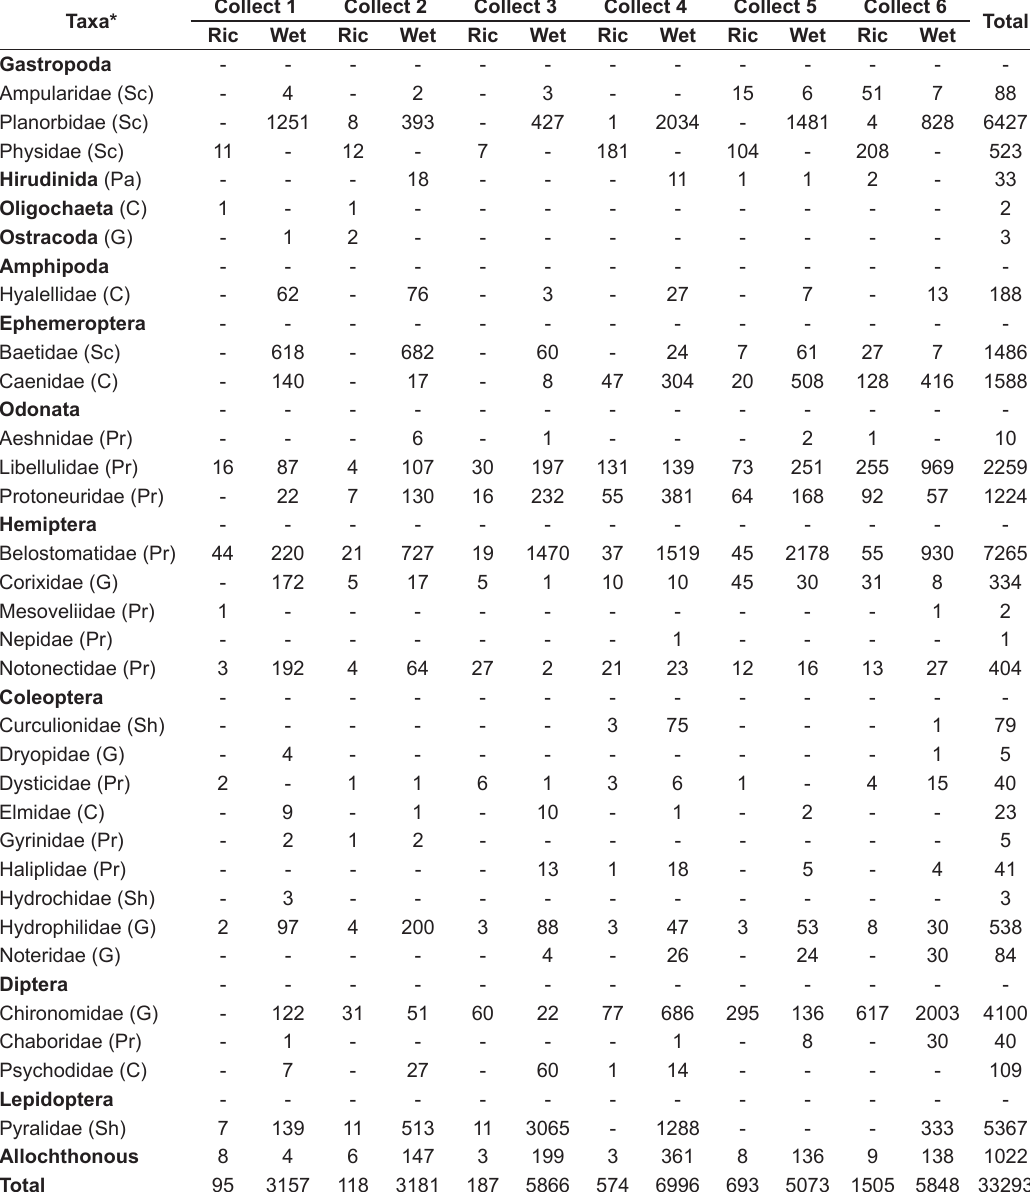
Table 2. Abundance of collected organisms at wetland (Wet) and rice cultivation